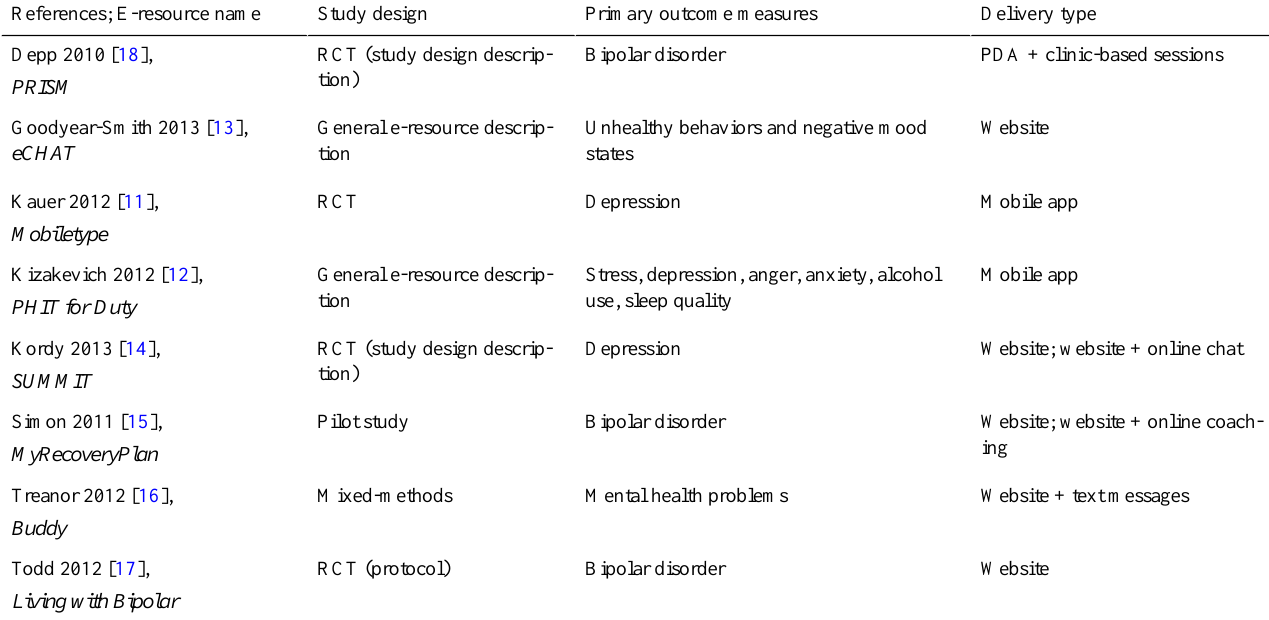
Table 1. Included studies and e-resources characteristics (abridged